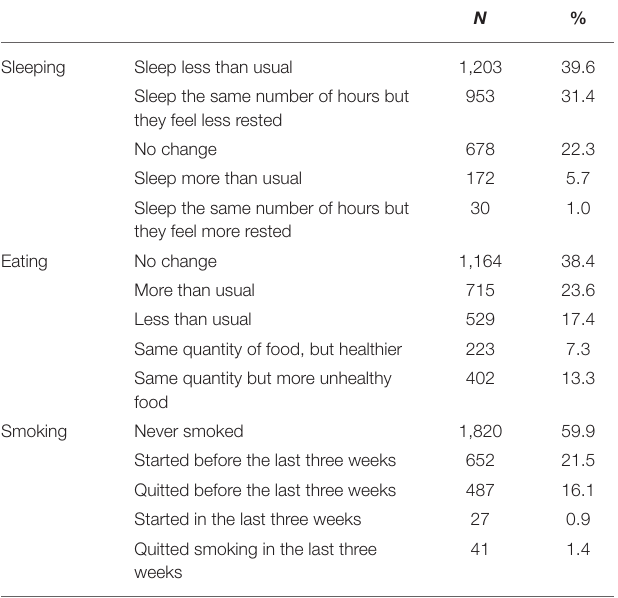
TABLE 2 | Stress symptoms.